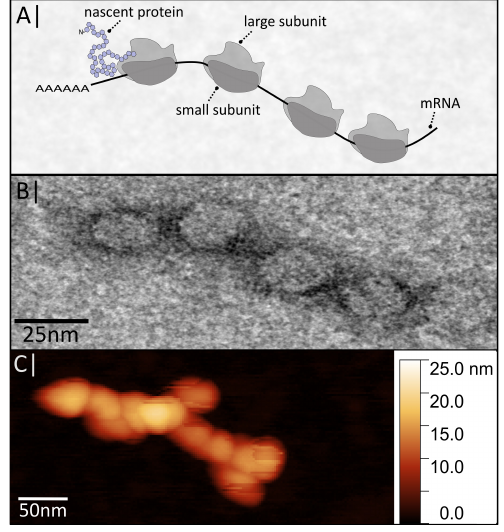
Figure 1. ( A ) Schematic supramolecular structure of a polysome. ( B ) Electron microscopic image of a polysome. ( C ) Polysomes imaged by atomic force microscopy. Shown micrographs are own results. See Appendix A Material and Methods A1 for detailed information